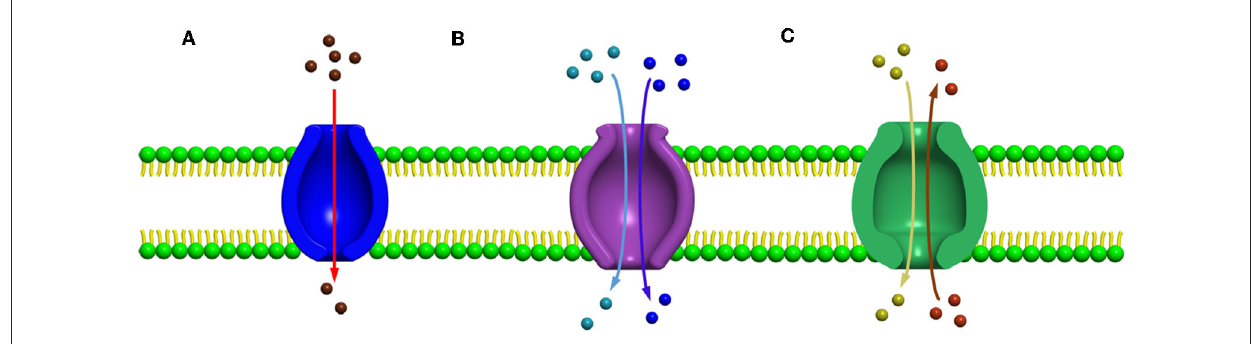
Resistance nodulation division (RND) superfamily